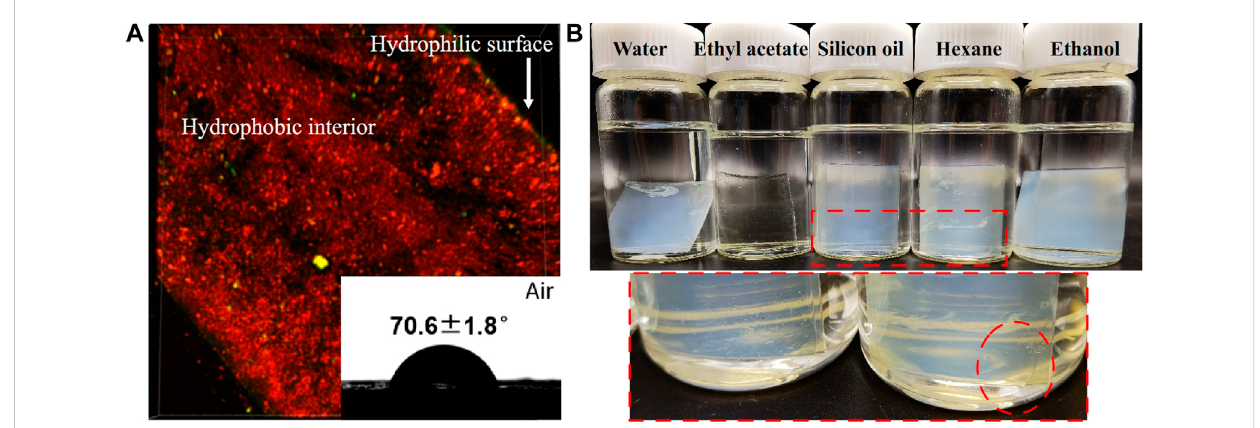
FIGURE 4 The wettability and solvent displacement test of PMAA/PEI gel. (A) The cross section of gel dyed by sodium fl uorescein and DiI is mainly oleophilic but shows hydrophilic on the surface. The contact angle of water on the fl at surface reaches 70.6 ± 1.8 ° ; (B) The photo of PMAA/PEI gel soaked in water, ethylacetate,siliconeoil,n-hexaneandethanolfor72 hshowthatitbecomestransparentwhensoakedinethylacetate, whilepartofthewaterinthegel soaked in silicone oil and n-hexane can be replaced by organic solvents.